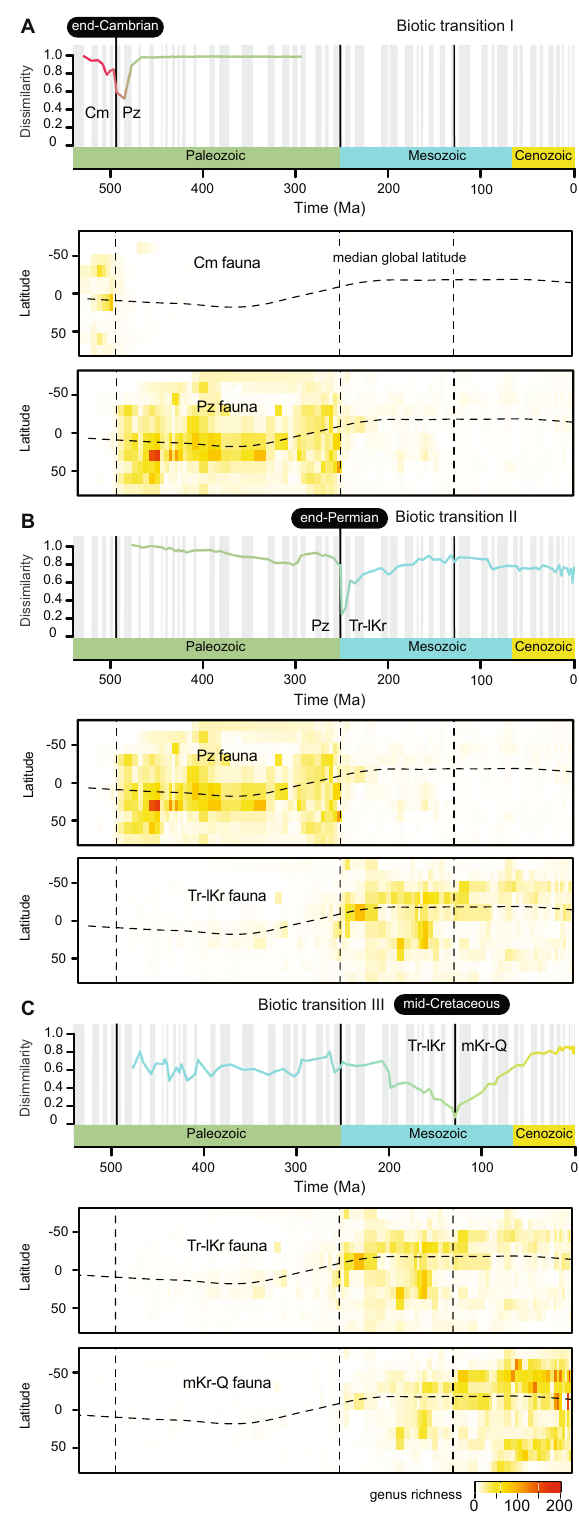
The three major biotic transitions among the Phanerozoic marine mega-assemblages vary in timing and potential causative drivers. The end-Cambrian mega-assemblage shift appears to be an abrupt transition at the base of the uppermost Cambrian stage (Fig. 3A). However, the limited number of fossil occurrences from that interval precludes a better understanding of the transition.